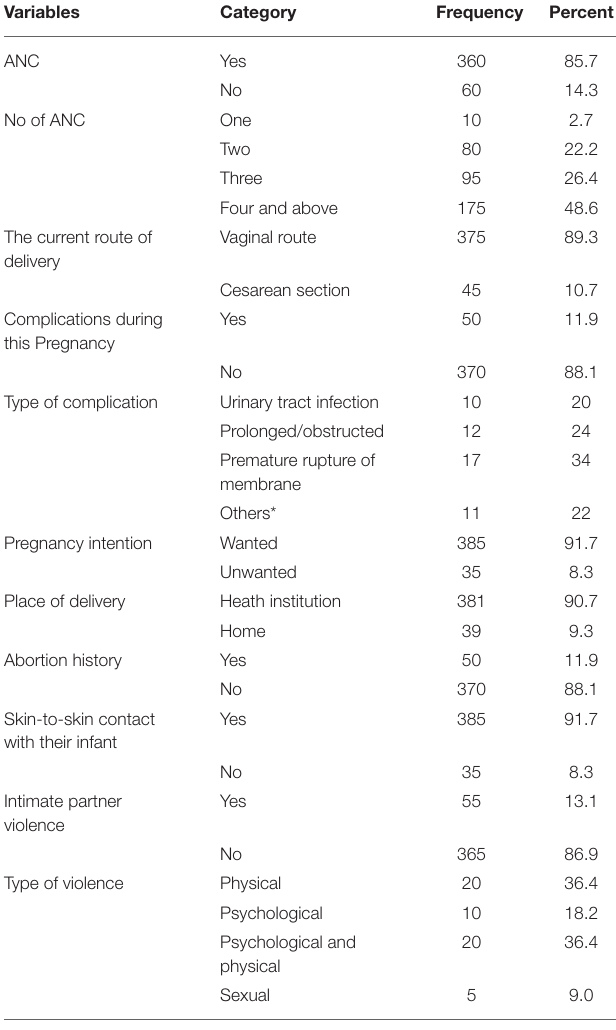
TABLE 2 | Maternal obstetric- related characteristics of post-partum mothers in Debre Tabor Town North West Ethiopia 2021. Variables